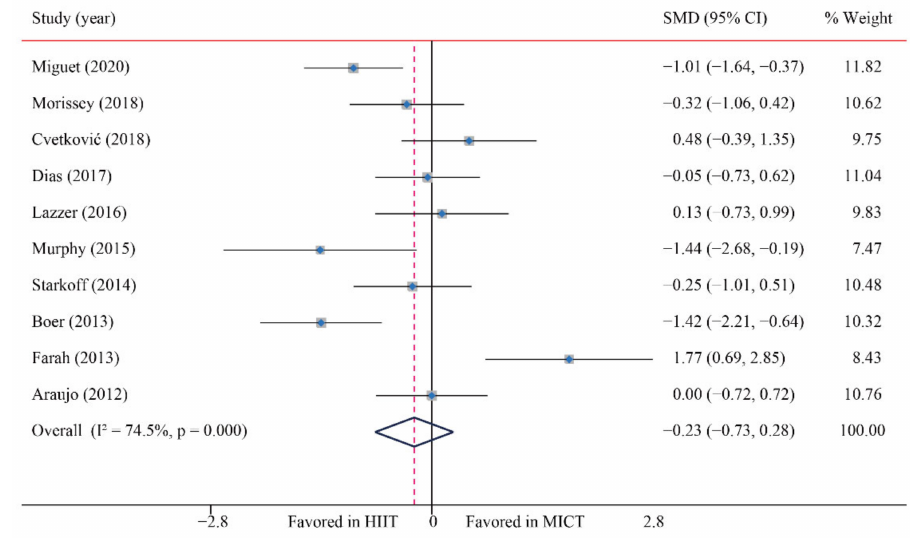
Figure 4. Effect of HIIT versus MICT on body fat percentage.